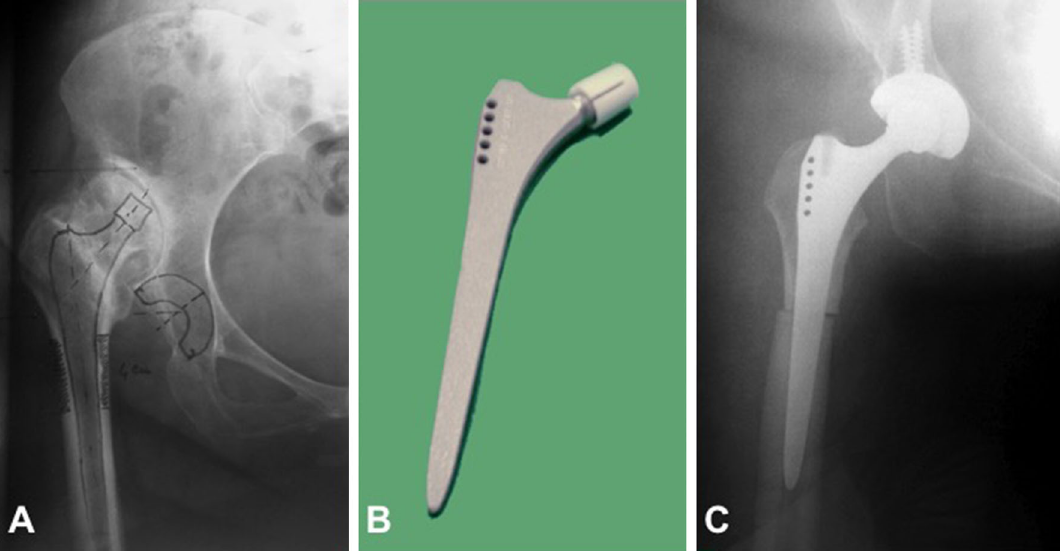
Fig. 2 39-year-old male patient with unilateral Crowe type IV DDH. a Pre-operative planning with cementless THA and transverse shortening osteotomy. b Quadrangular cross-section CSR Japan stem (Sulzer (cid:3) , Switzerland). c Post-operative